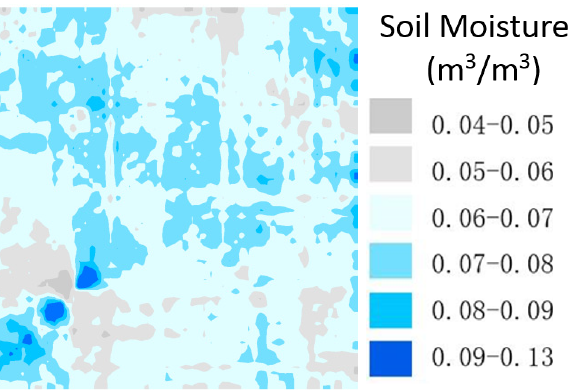
Figure 6. The location of the study area. Referenced spatial distribution map of soil moisture in Plot D.